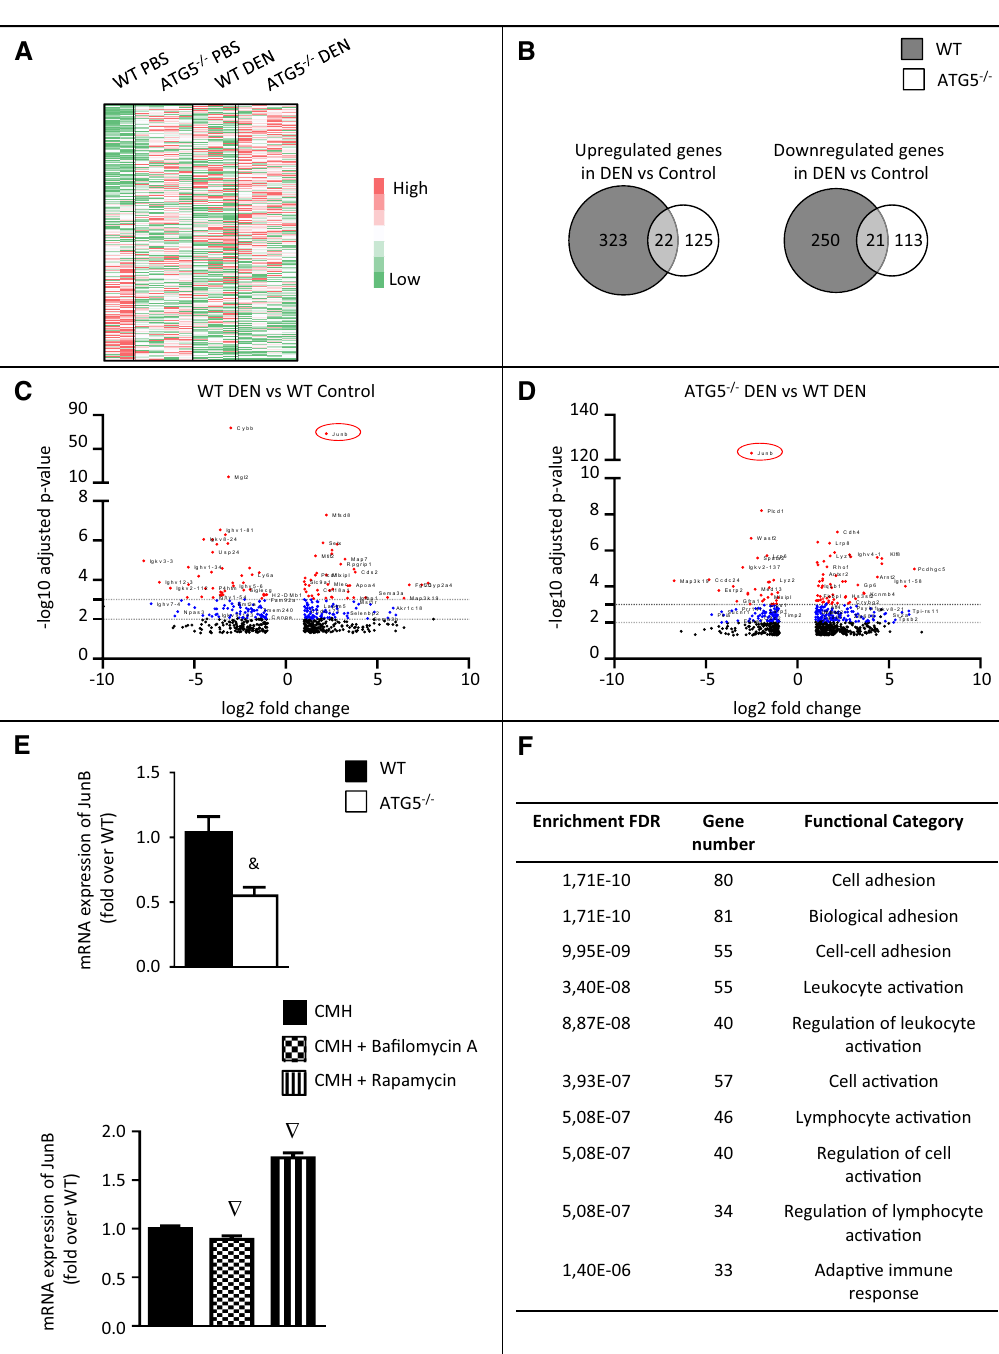
Figure 4. Sorted ATG5 −/− macrophages display a typical transcription program. ( A ) Heat map of the genes differentially expressed (using a threshold of twofold change and p value < 0.05) between WT and ATG5 −/− hepatic macrophages isolated from mice after control or DEN treatment. ( B ) Venn diagram for upregulated (left) and downregulated (right) genes in DEN vs Control WT or ATG5 −/− macrophages. ( C ) Volcano plot of the differentially expressed genes of WT macrophages sorted from DEN-treated mice as compared to WT macrophages sorted from control mice. ( D ) Volcano plot of the differentially expressed genes of ATG5 −/− macrophages sorted from DEN-treated mice as compared to WT macrophages sorted from DEN-treated mice. ( E ) RT-PCR analysis of JunB mRNA expression in peritoneal macrophages isolated from WT or ATG5 Mye−/− mice (upper panel) and in peritoneal macrophages exposed to the conditioned medium of Hepa1-6 cells (CMH) in the presence or absence of 100 nM bafilomycin A or 100 nM rapamycin. Data are shown as mean ± SEM of 6 samples per condition. & p < 0.05 for WT vs ATG5 −/− , ∇ p < 0.05 for CMH vs CMH + bafilomycin A or CMH + rapamycin. ( F ) Gene ontology enrichment analysis show the top 10 modulated pathways by p-value enriched (false discovery rate, FDR) for genes significantly upregulated in ATG5 −/− macrophages isolated from DEN-treated mice. n = 3 for WT DEN, n = 4 for ATG5 −/− PBS, n = 3 for WT DEN; n = 4 for ATG5 −/−